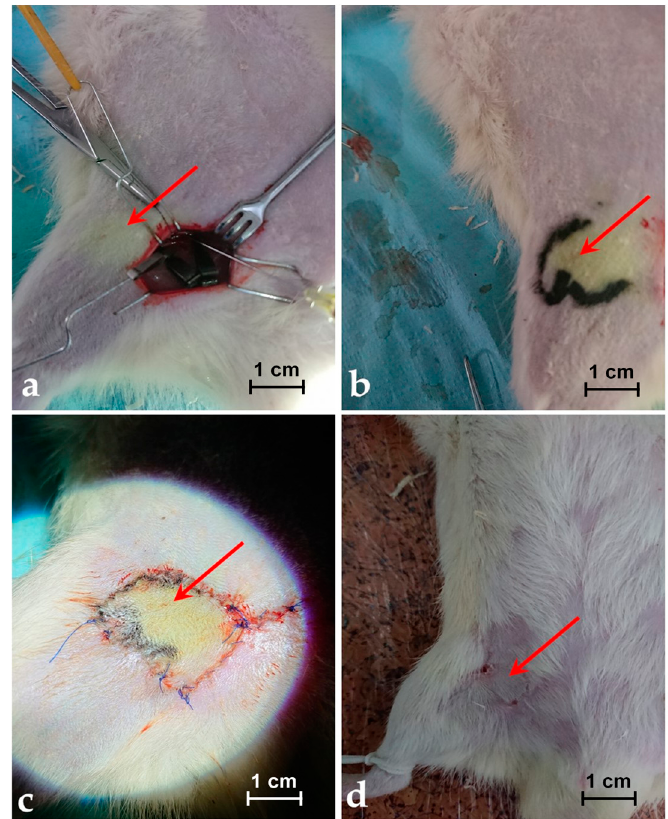
Figure 5. ( a ) Image of the skin zone coloured by PRO. ( b ) Image with the margins/edges of the functional perforasome marked for better view. ( c ) Image with the skin perforasome island after rising and suturing. ( d ) Image with the flap integrated on the 14th day after operatory procedure.